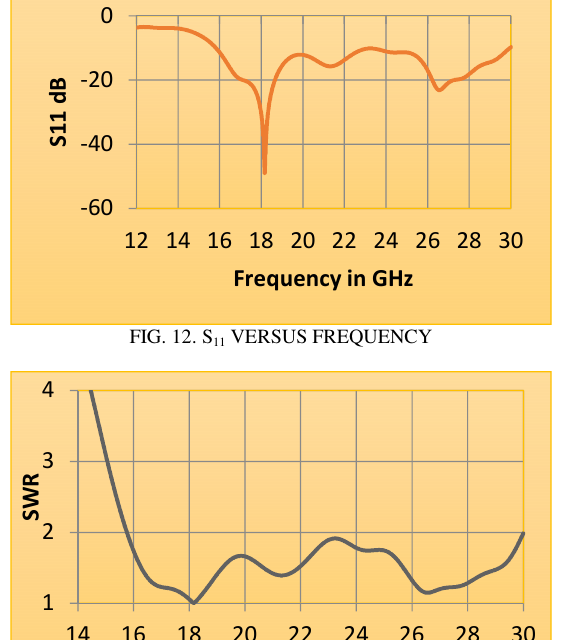
FIG. 17. VSWR VERSUS FREQUENCY OF THE FABRICATED